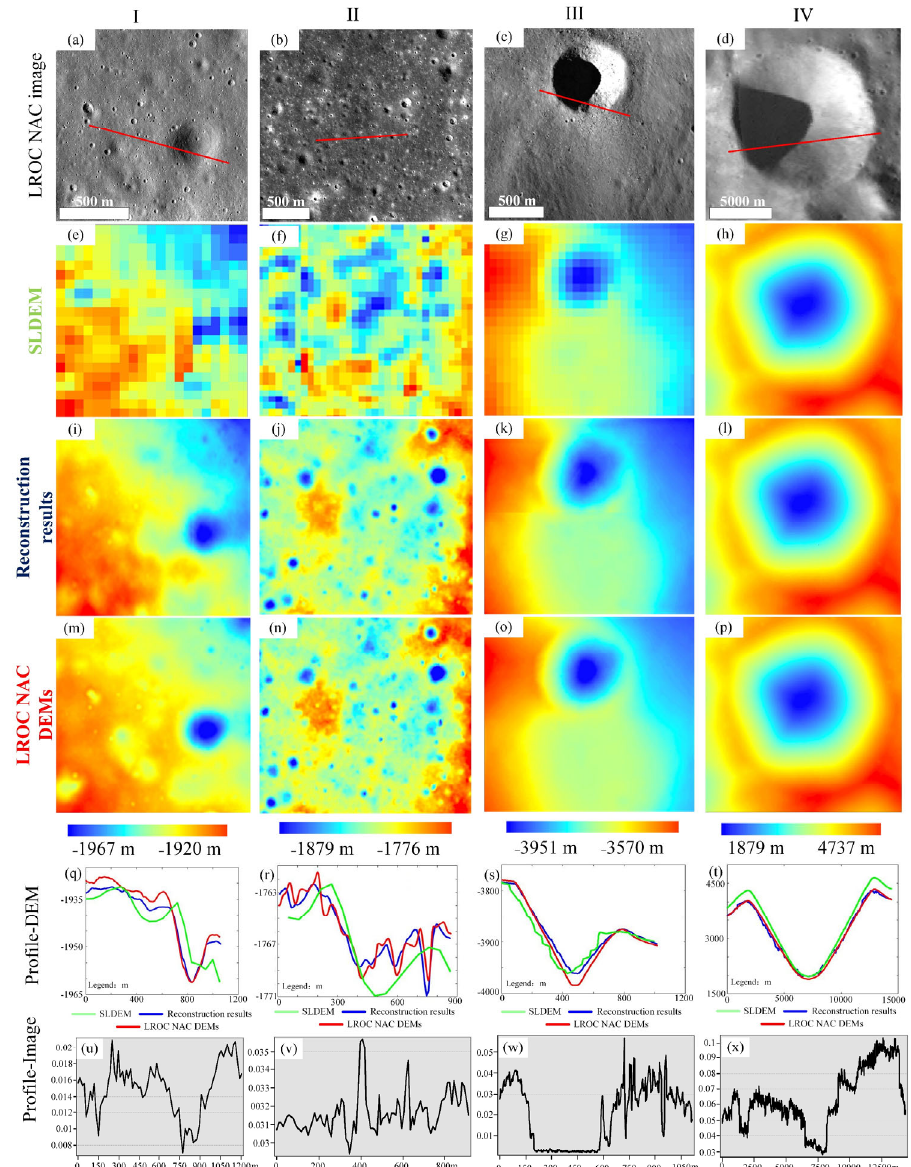
Figure 6. More detailed analysis of the results in the four subareas I–IV annotated in Figure 5. Each column shows one subarea. Row 1: LROC NAC image of 2 m/pixel showing the zoomed subareas. Row 2: SLDEM of 60 m/pixel. Row 3: network reconstruction results of 2 m/pixel. Row 4: LROC NAC DEM of 2 m/pixel as ground truth for comparison purposes. Row 5: DEM profiles of the four subareas with their profile locations shown in the first row. The green curves represent SLDEM, the blue curves represent network reconstruction results, and the red curves represent LROC NAC DEMs. Row 6: gray scale profiles of the LROC NAC image.